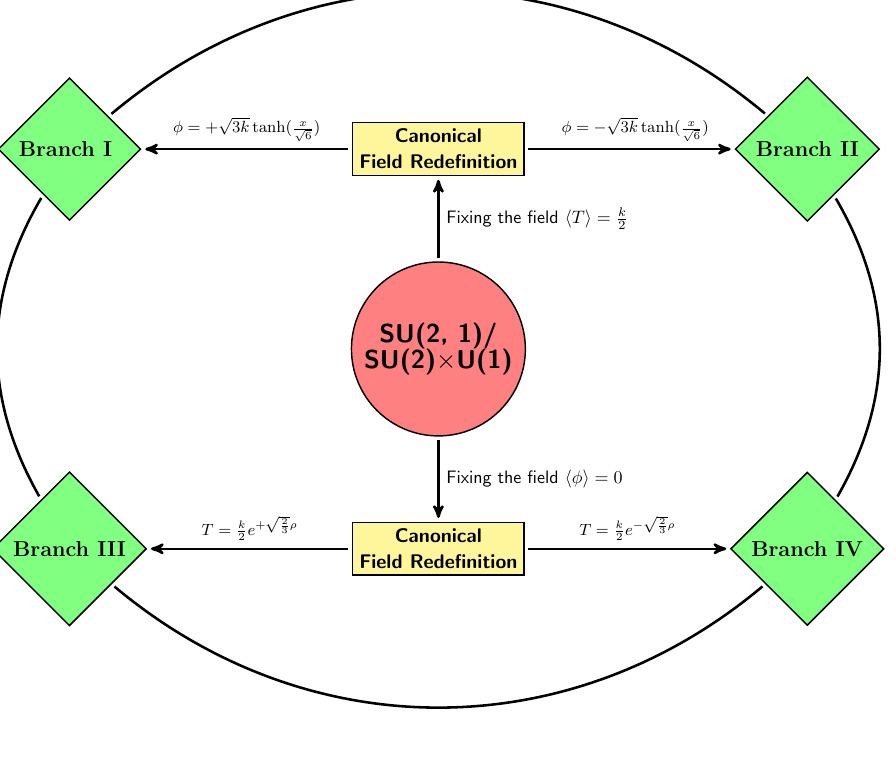
Figure 1 . This diagram shows how, starting from a general two-(cid:12)eld superpotential W ( T; (cid:30) ), it is possible to break the SU(2,1)/SU(2) (cid:2) U(1) symmetry by (cid:12)xing one of the complex scalar (cid:12)elds and then casting the dynamical (cid:12)eld in canonical form by a suitable (cid:12)eld rede(cid:12)nition, yielding four distinct branches of models with Starobinsky-like e(cid:11)ective scalar potentials.